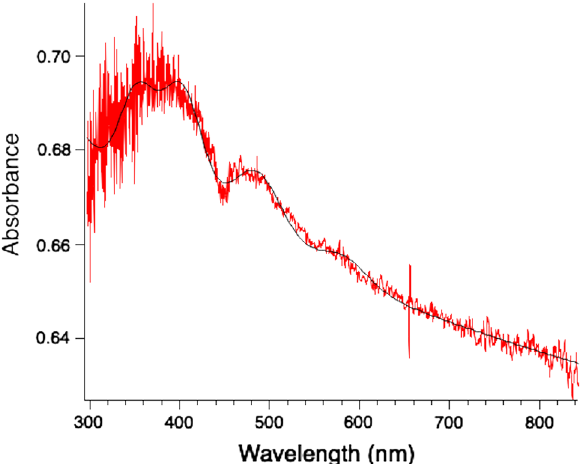
Figure 6. Absorbance of SM2 crystal, with fitted curve (black). The exposure time was 8 ms and number of accumulations 500. No data filter was applied. Curve fitting via Igor Pro 8 of Wavemetrics Inc.